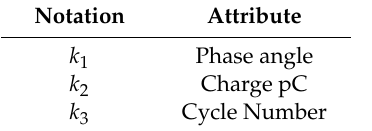
Table 1. Three attributes used in the PD pattern recognition.